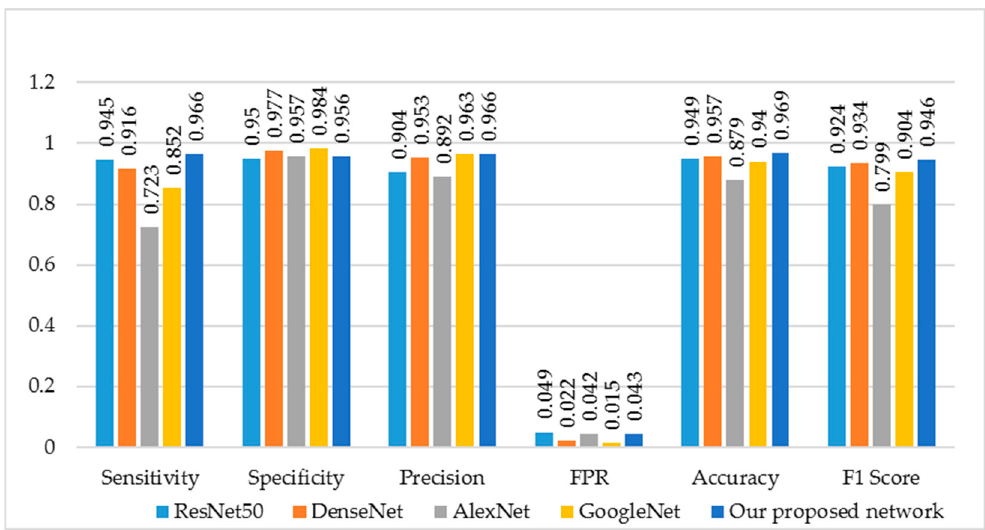
Figure 6. Summary of all models considering all evaluation parameters.